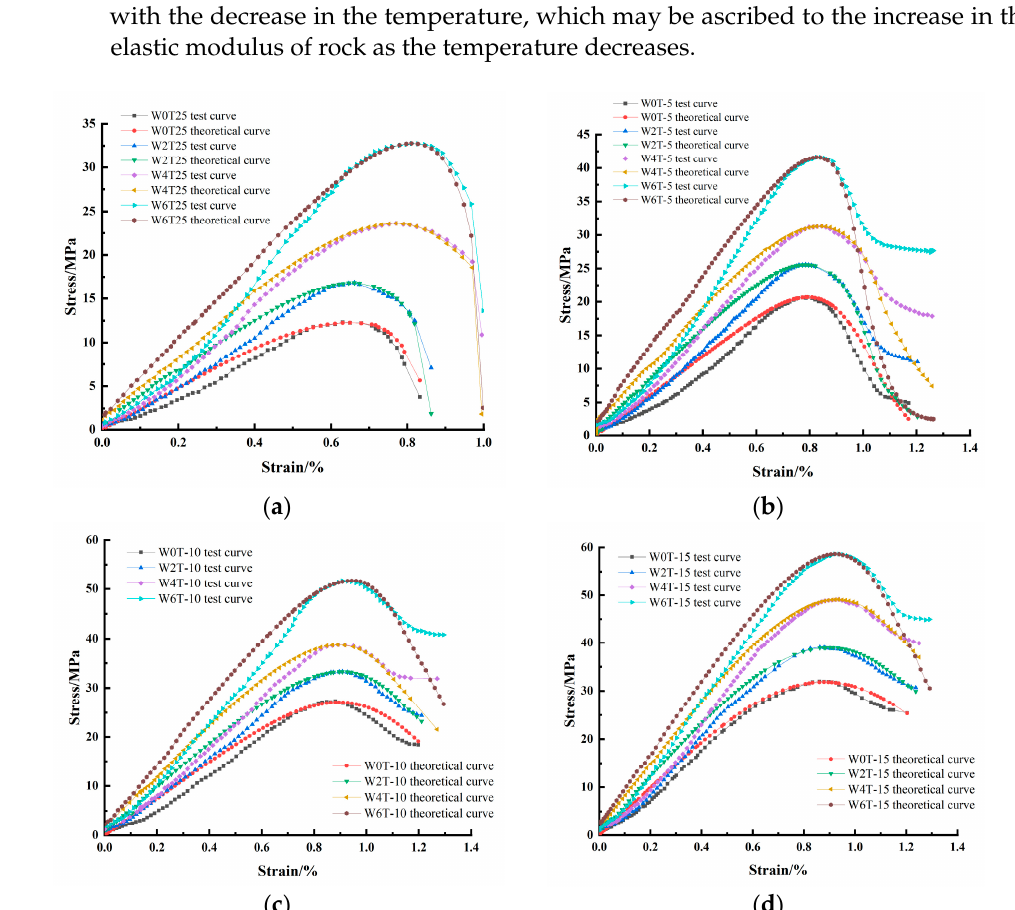
Figure 13. Comparison between experimental data and model data. ( a ) T = 25 ◦ C; ( b ) T = − 5 ◦ C; ( c ) T = − 10 ◦ C; ( d ) T = − 15 ◦